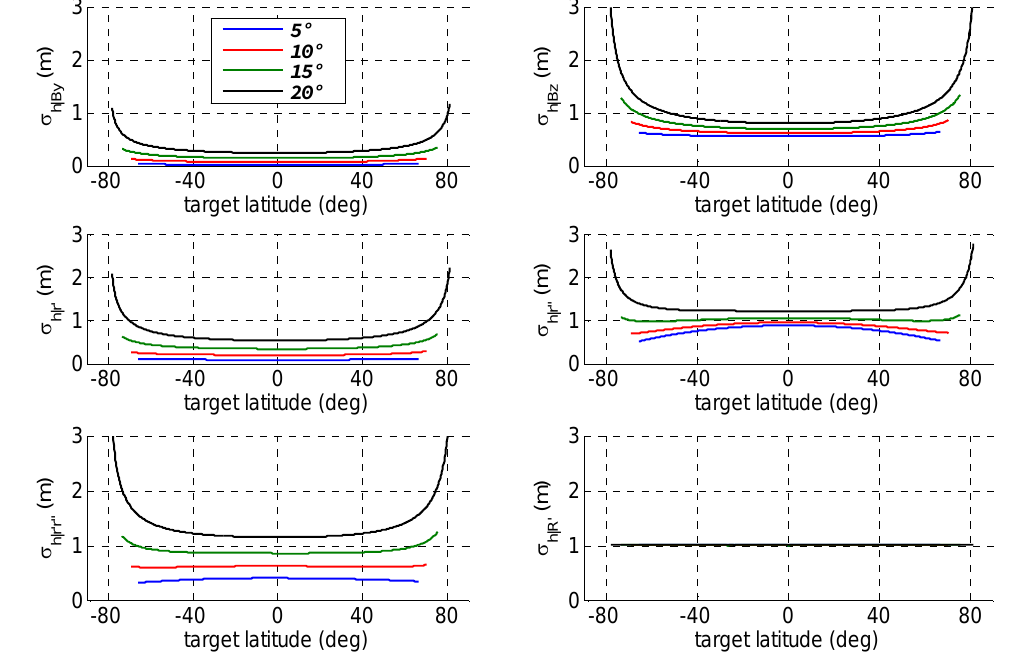
Figure 9. Contributions to height uncertainty as a function of target latitude in the method of projection of bistatic parameters for four bistatic antenna off-nadir angles (1/10 of an image pixel assumed as co-registration uncertainty).